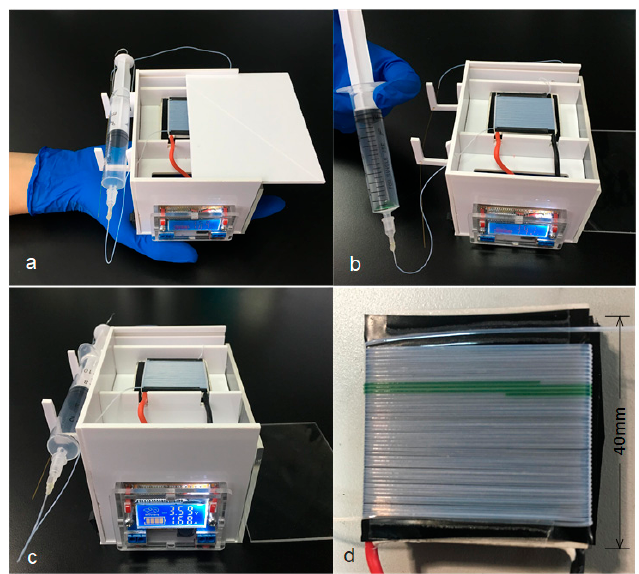
Figure 5. An image of the microdevice ( a – c ). The flow situation of the reagent ( d ).